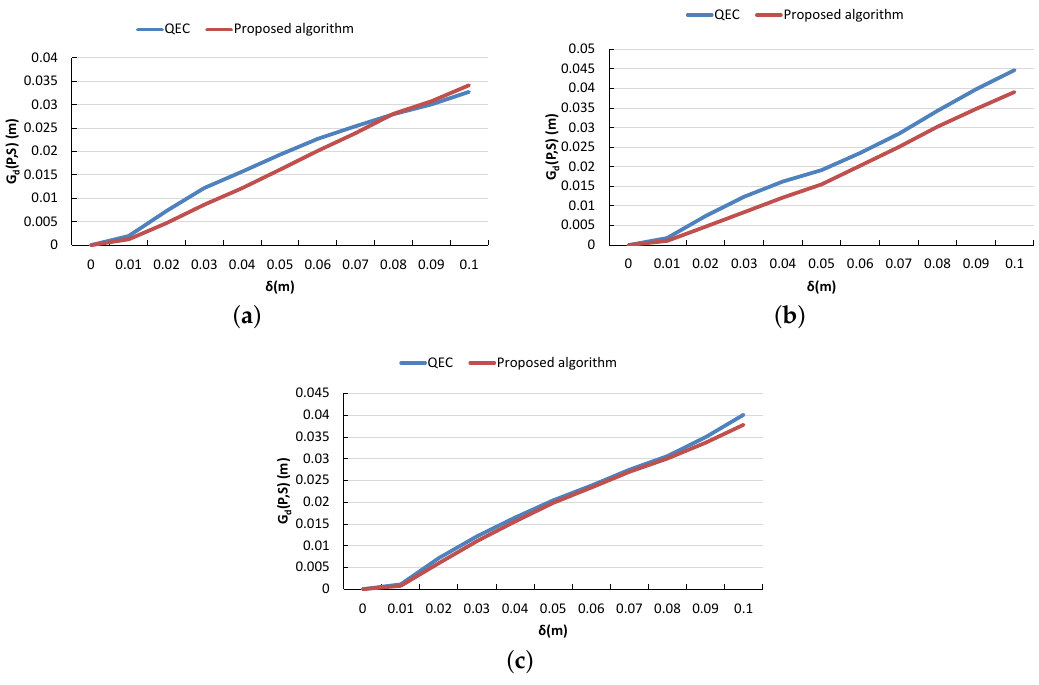
Figure 22. A comparison of the proposed algorithm versus the QEC technique in terms of G d ( P , S ) for Site A ( a ); Site B ( b ) and Site C ( c ).